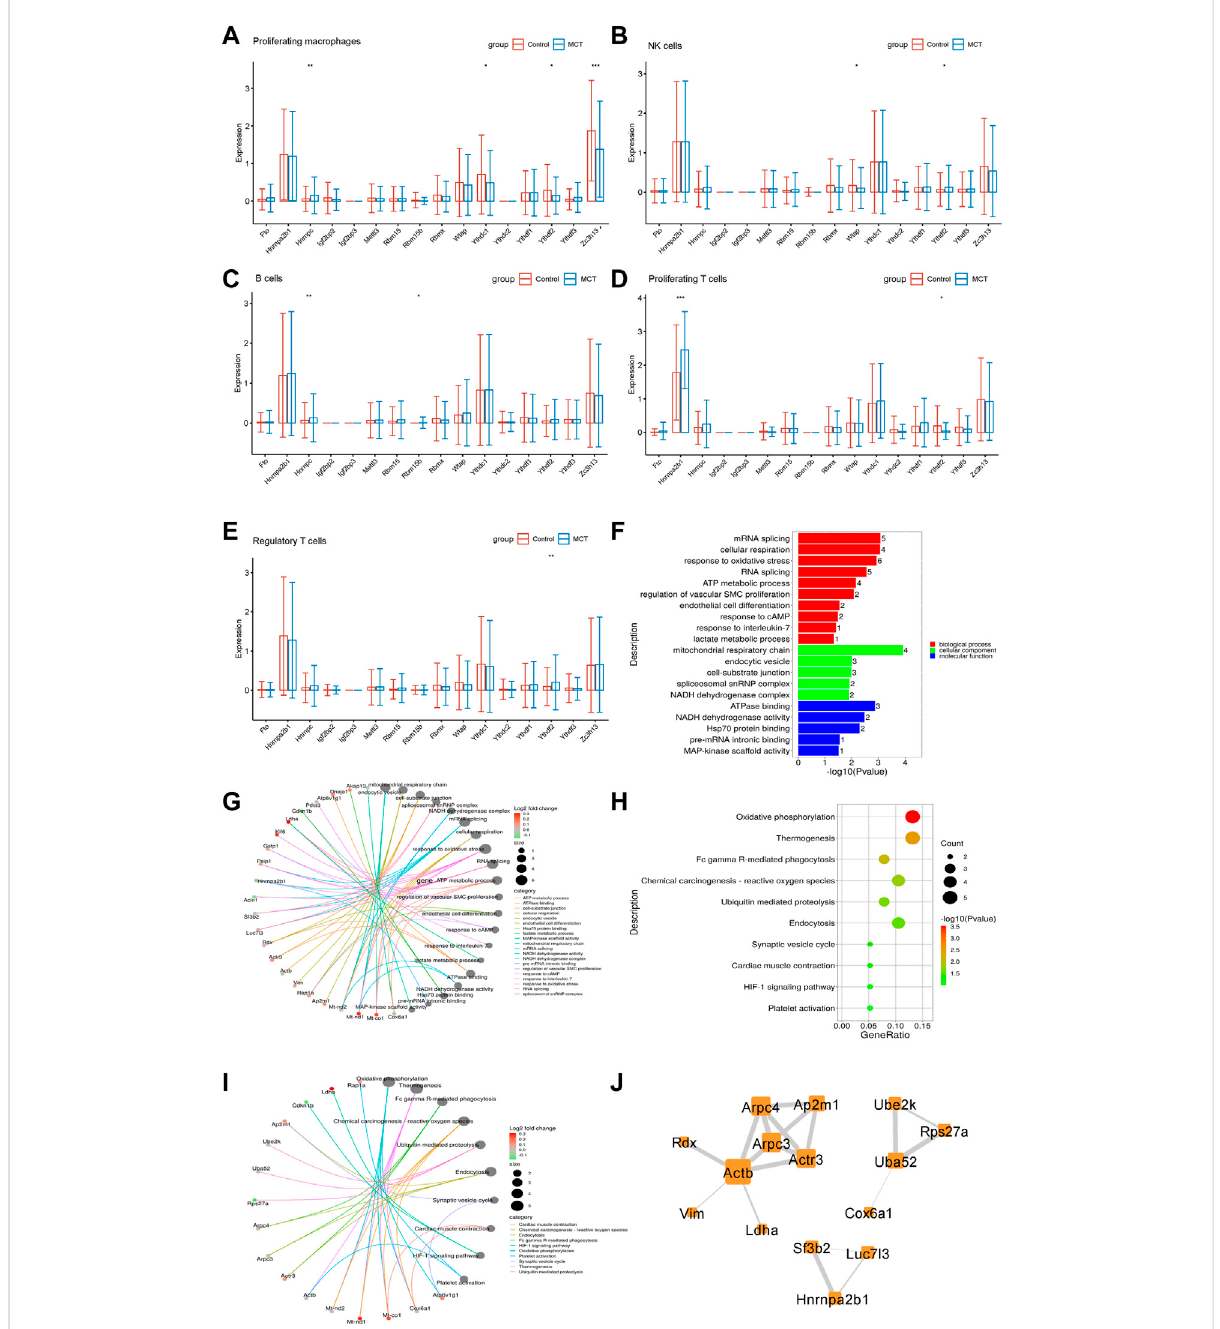
FIGURE 5 The expression of N6-Methyladenosine regulators was dysregulated in the immune systems. (A) The m6A regulators expressed differentially in interstitialmacrophages. (B) Them6AregulatorsexpresseddifferentiallyinNKcells. (C) Them6AregulatorsexpresseddifferentiallyinBcells. (D) The m6A regulators expressed differentially in proliferating T cells. (E) The m6A regulators expressed differentially in Tregs. (F) The GO analysis of the targetgenesofm6AthatoverlappedwiththeupregulatedDEGsinTregs. (G) ThegenesinvolvedintheenrichedpathwaysaredepictedinTregs. (H) The KEGG analysis of the target genes of YTHDC1 overlapped with the upregulated DEGs in Tregs. (I) The genes involved in the enriched pathways are depicted in Tregs. (J) The hub networks constructed based on the genes depicted